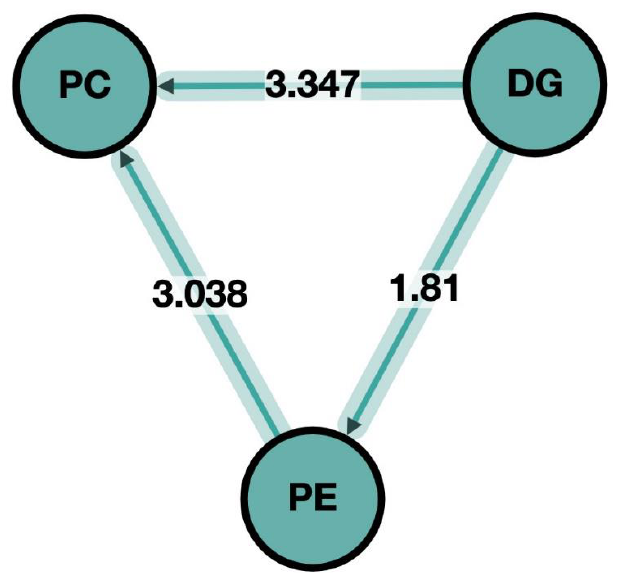
Figure 2. Lipid pathway analysis after participants consumed the soybean oil (SO) and partially- hydrogenated soybean oil (PHSO) enriched diets. The biosynthesis of phosphatidylcholine (PC) from DG and phosphatidylethanolamine (PE) was upregulated after participants consumed the PHSO-enriched diet rather than the SO-enriched diet. Z scores over three were considered significant pathways.